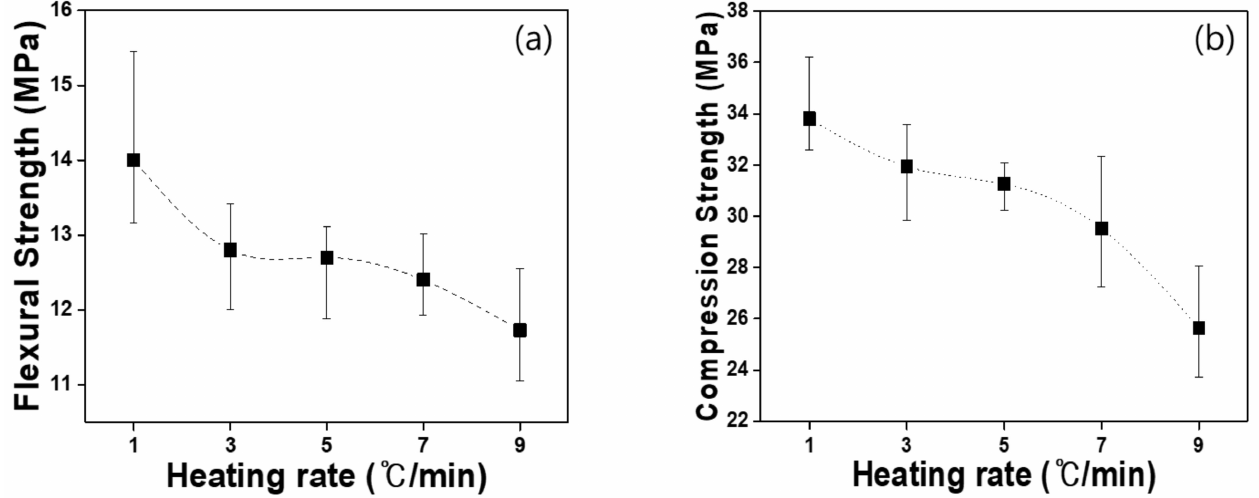
Figure 5. Mechanical strength of graphite blocks as a function of heating rate: ( a ) flexural strength, ( b ) compression